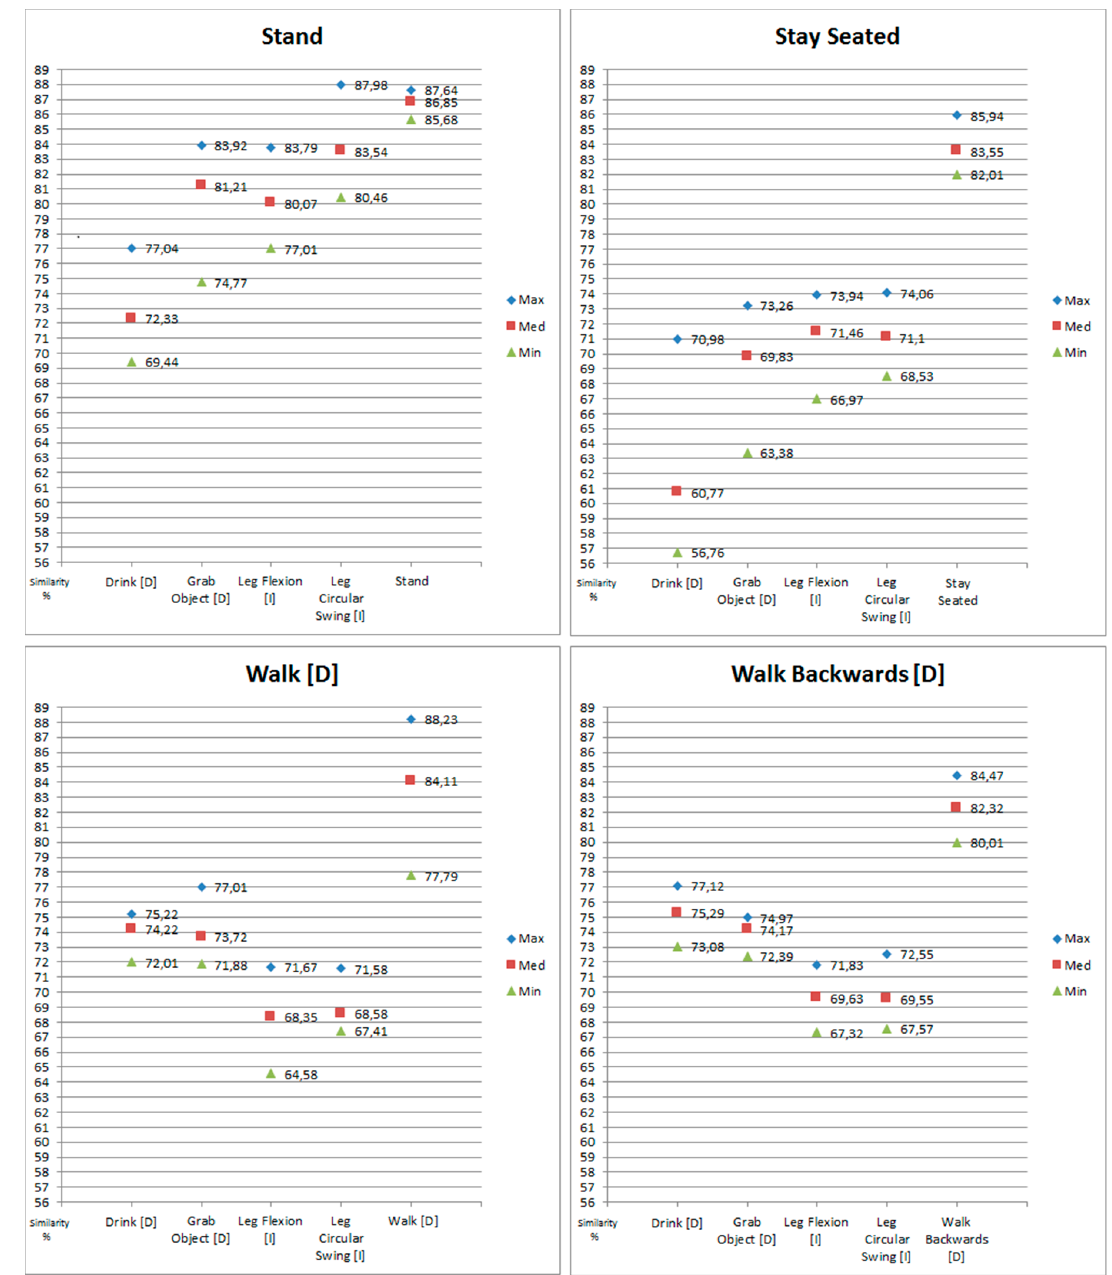
Figure 3. Graphical Representation of the Limit Selection Pre-Evaluation Results.